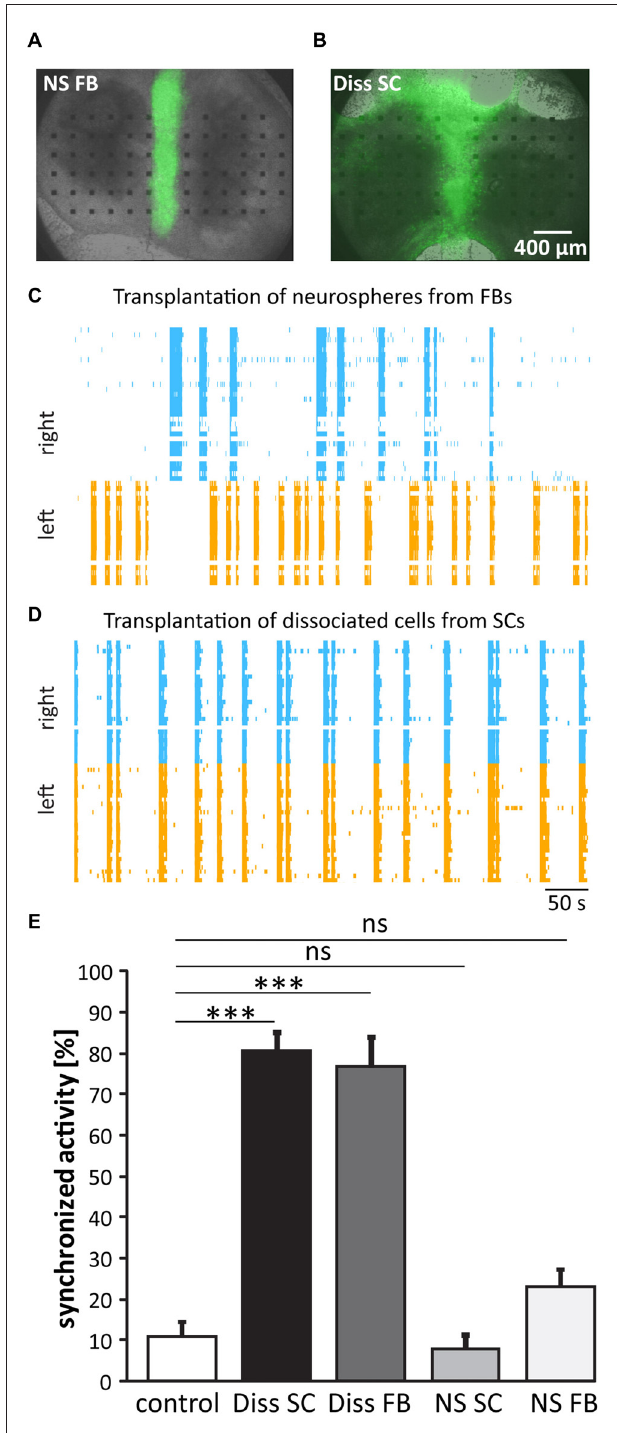
FIGURE 2 | Functional regeneration after cell transplantation. (A,B) Pictures of SC cultures 3 weeks after the grafting of forebrain (FB) neurospheres (NS) and dissociated spinal cord (Diss SC) from green fluorescent protein (GFP) rat embryos. (C,D) Representative raster plots of cultures that received FB NS (C) or Diss SC cells (D) . Only in the latter case